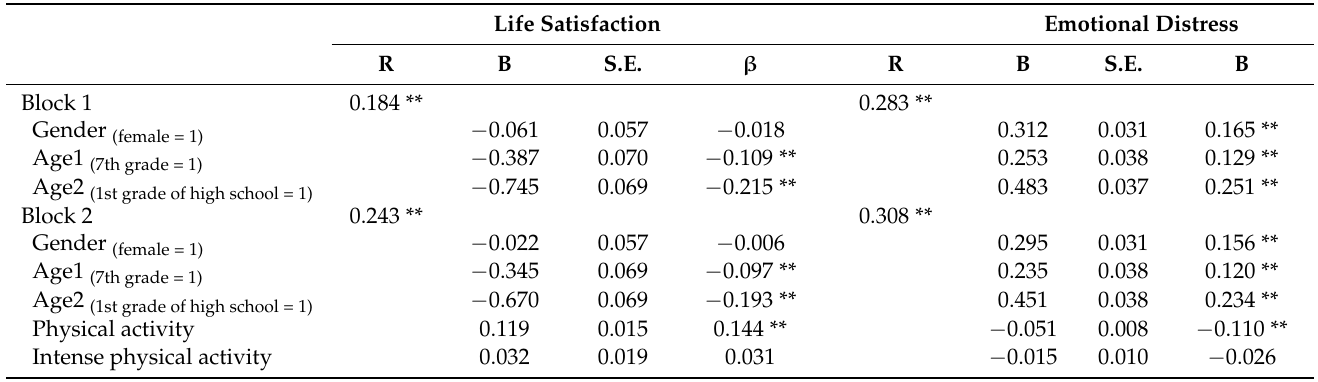
Table 3. Multiple Regression Analysis: Contribution of Physical Activity to Life Satisfaction and Emotional